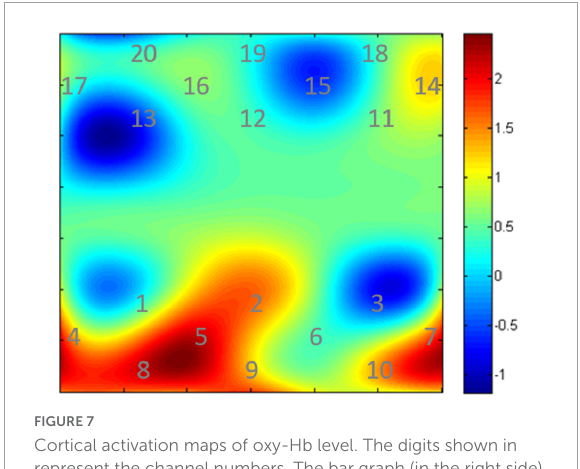
FIGURE7 Cortical activation maps of oxy-Hb level. The digits shown in represent the channel numbers. The bar graph (in the right side) shows the t